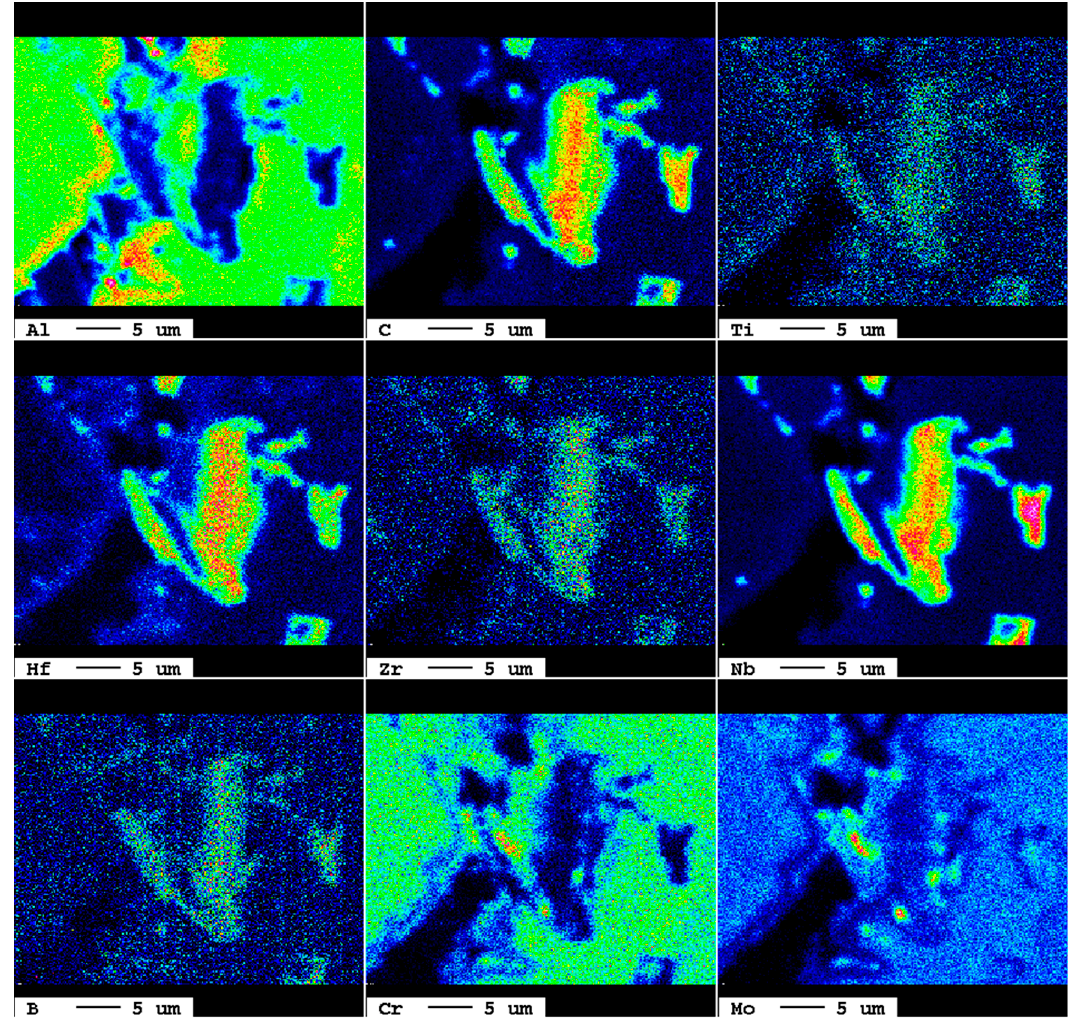
Figure 6. BSE image of FESEM of the liquated carbides in the HAZ and EPMA maps of the Al, C, Ti, Hf, Zr, Nb, B, Cr, Mo elements in the MC carbides.